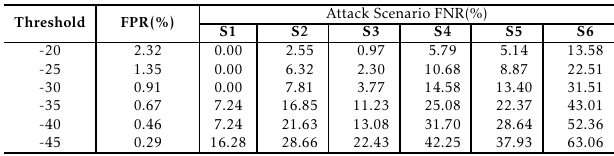
Table 4. Experimental results for the Markov chain model for the attack strategy of focusing on high cost requests.